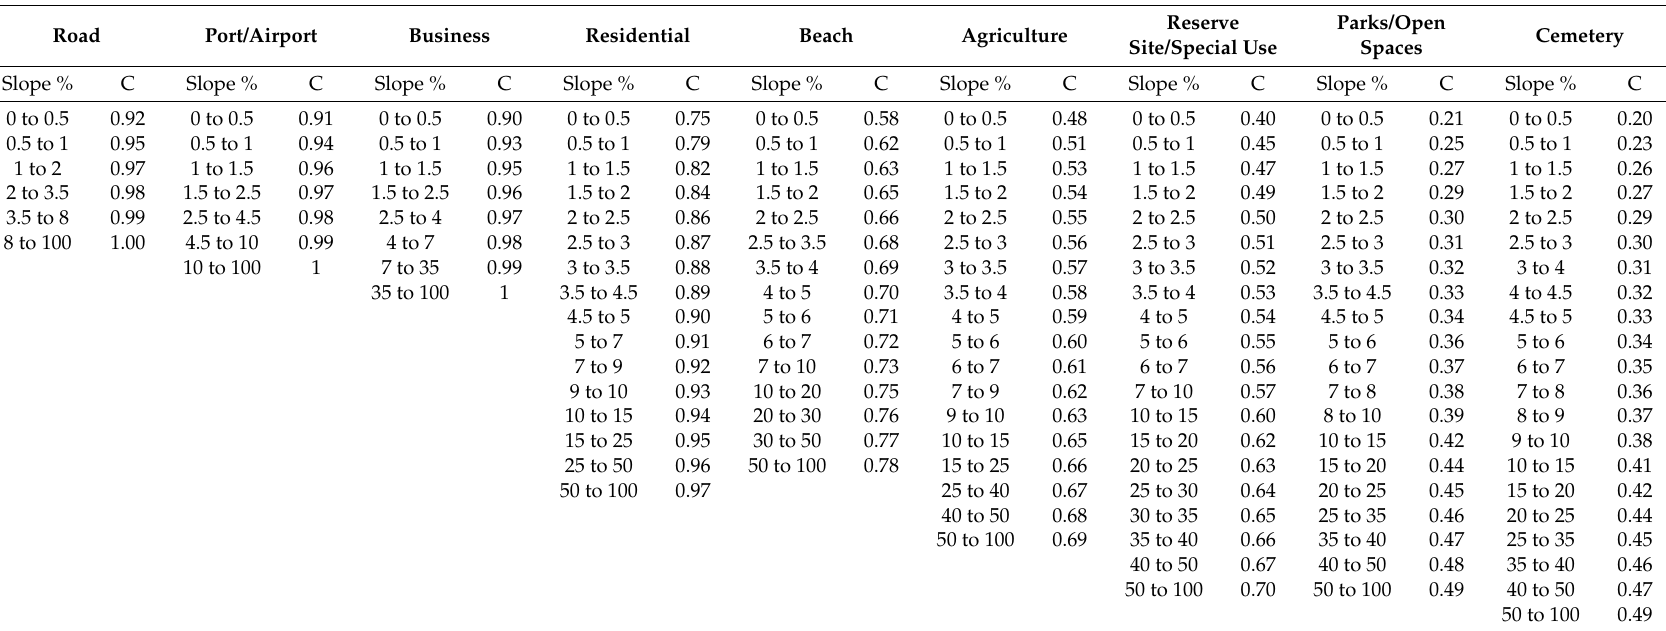
Table 2. C values for different land uses and slopes in